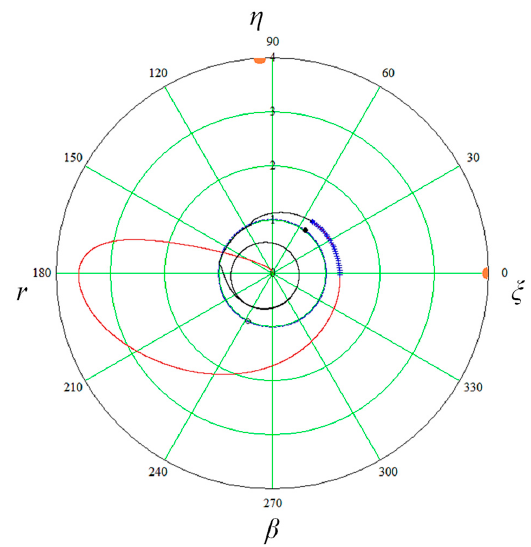
Figure 16. The trajectory of the spacecraft. The solid black curve shows the section of the circumlunar motion of the SC, starting from the passage of the vicinity of the L 2 point and up to the exit from the Moon’s gravity sphere through the L 1 point with a further transition to the geocentric orbit.